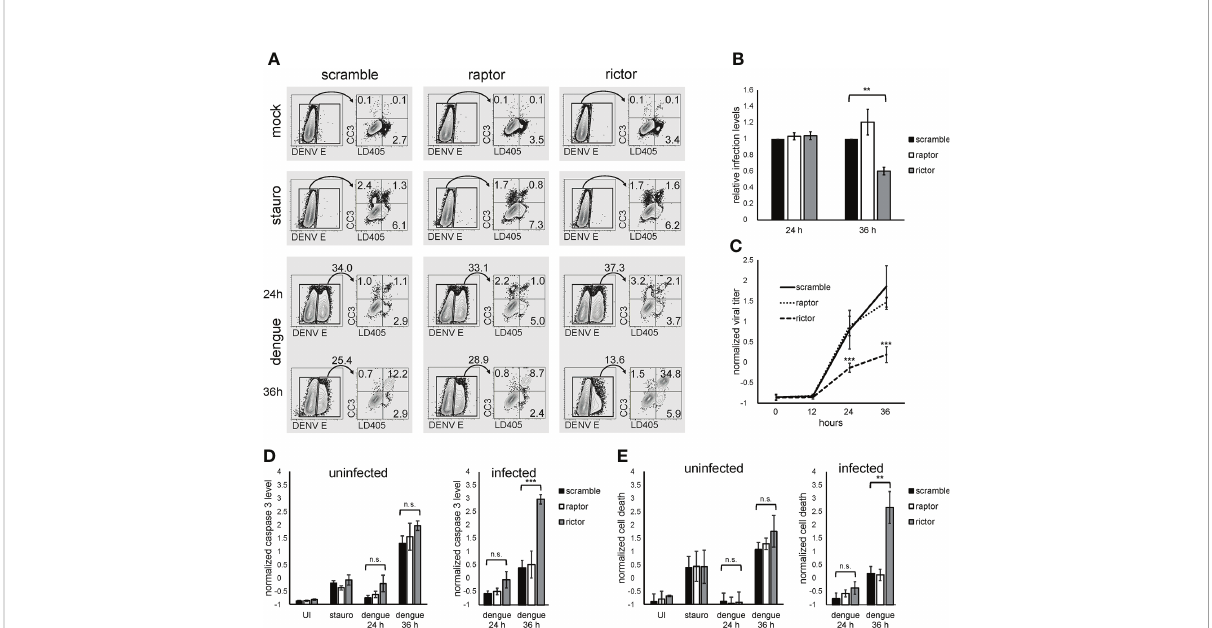
FIGURE 4 mTORC2 inhibition leads to increased dengue-induced apoptosis and cell death. (A) , HepG2 cells were infected with dengue at MOI of 4 for 24 or 36 h, mock treated, or treated with 5 µM staurosporine overnight. Cells were then collected and stained with a cell-impermeable amine reactive dye (LD405), followed by fi xation, permeabilization, and staining with anti-activated caspase 3 and anti- fl avivirus E protein antibodies. Infected (E-positive) cells were gated and activated caspase 3 (CC3) and LD405 expression were analyzed within that population. Numbers represent population frequencies in each gate/quadrant. (B) , Cells were treated as in (A) , and the percent of infected (E-positive) cells was calculated. The bar graph shows the average values for 3 independent experiments, each normalized to the scramble condition. (C) , Cells were treated as in (A) , and the amount of infectious virus present in the supernatant was quanti fi ed at the indicated timepoints. The bar graph represents Z-normalized average values from 3 independent experiments. (D) , Cells were treated as in (A) , and the percent of infected cells positive for caspase 3 was calculated. The bar graph represents Z -normalized values from 3 independent experiments. (E) , Cells were treated as in (A) , and the percent of infected cells positive for LD405 was calculated. The bar graph represents Z -normalized values from 3 independent experiments. p values are derived from 2-tailed Student ’ s t test; n.s., not signi fi cant; ** denotes p < 0.01, and *** denotes p <